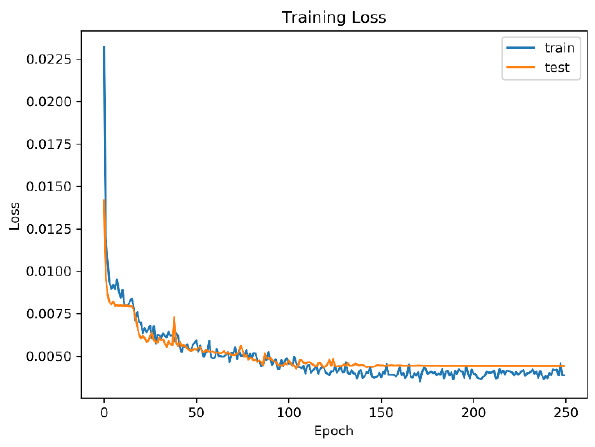
Figure 12. Training data loss and test data loss during training. Table 7. Comparison of errors among di ff erent